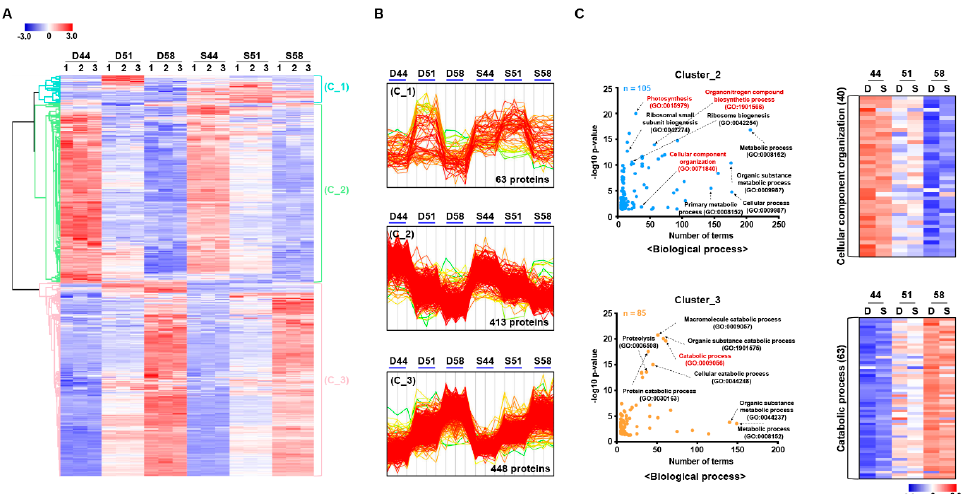
Figure 6. Hierarchical clustering analysis ( HCA) clustering and gene ontology (GO) enrichment analysis of the differentially modulated proteins of seed filling stage samples. Heatmap ( A ) and abundance profile ( B ) showing the distribution of 924 significantly modulated proteins were divided into three major clusters based on their abundance among six samples. ( C ) The biological process of GO analysis shown distinct terms in each cluster mainly involved in the cellular component organization in cluster_2 and catabolic process in